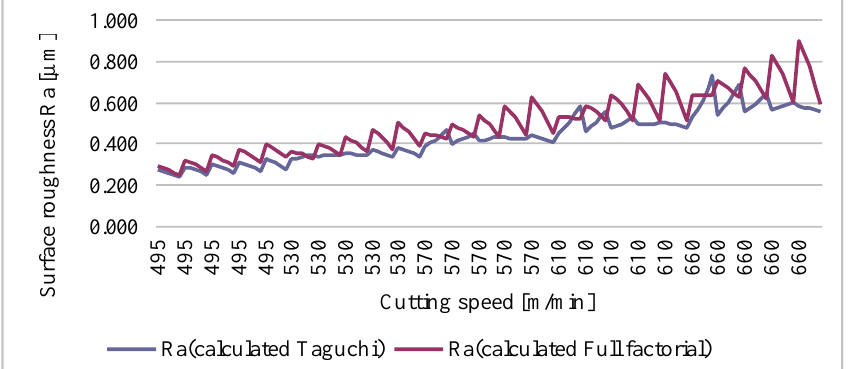
Figure 10. Comparison between the relative errors obtained (Taguchi′s method versus central composite design).